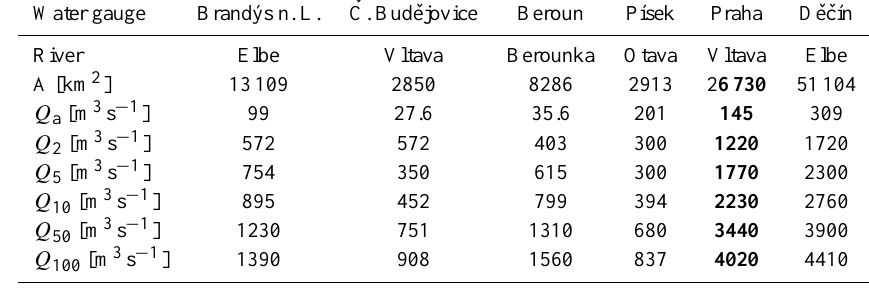
Table 1. Important data on floods in the Elbe catchment. Values for major profiles are in bold. Water gauge Brandýs n. L.